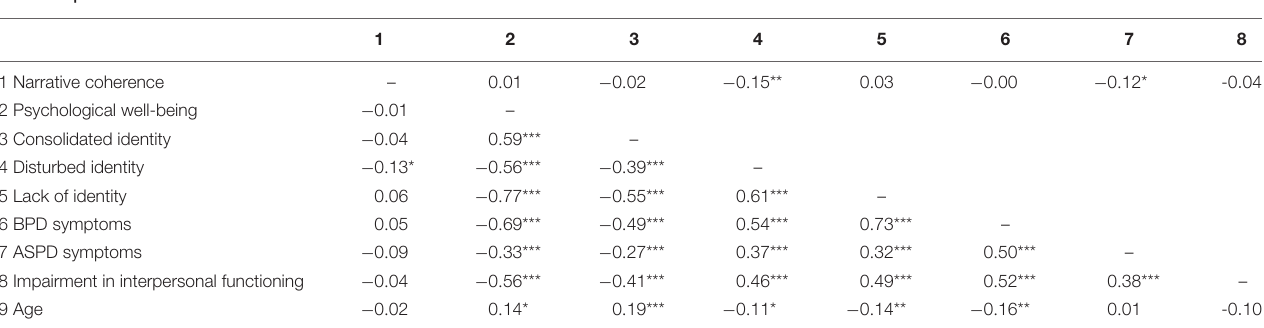
TABLE 2 | Pearson correlation coefficients between main